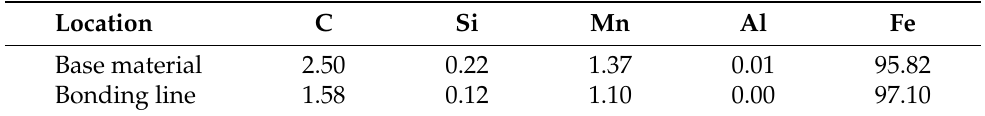
Table 3. Analysis of the chemical composition with energy dispersive spectroscopy (EDS) in the base material and in the bonding line in wt%.